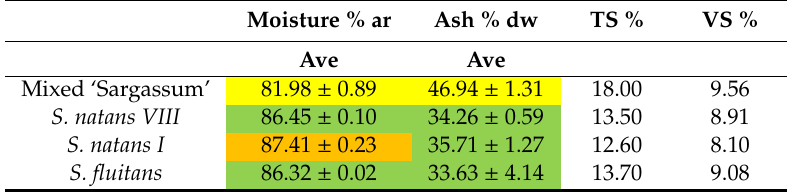
Table 1. The moisture, ash Total Solids (TS) and Volatile Solids (VS) of Sargassum inundation (“Mixed Sargassum”) and pelagic species of Sargassum from Turks and Caicos. Di ff erences in colour within a column indicate statistically significant di ff erences between samples ( p < 0.05) ( n = 3). ar = as received; dw = dry weight and ww = wet weight.